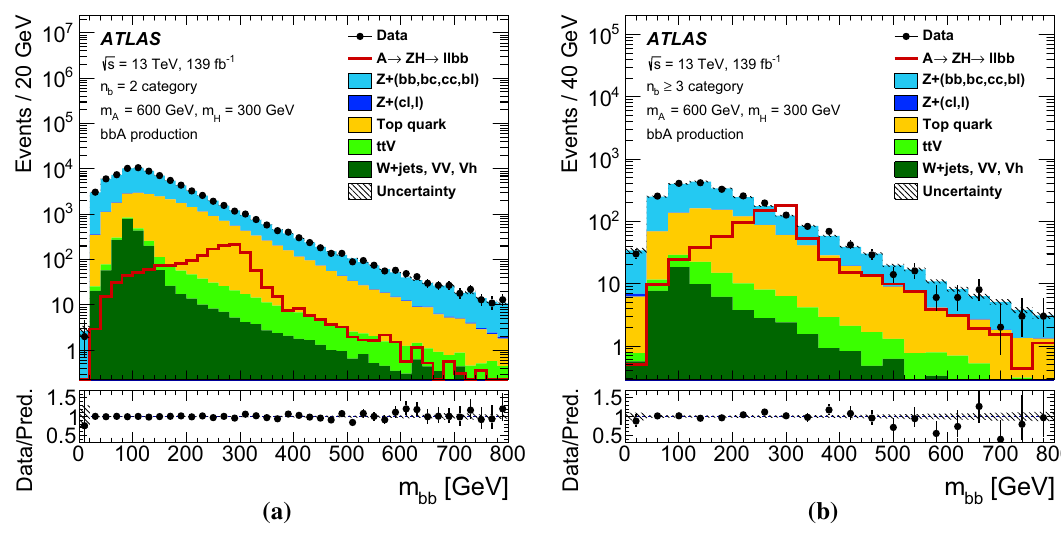
Fig. 7 The m bb distribution before any m bb window cuts for the a n b = 2 and b n b ≥ 3 categories. The signal distribution for ( m A , m H ) = (600, 300) GeV is also shown, and is normalised such that the